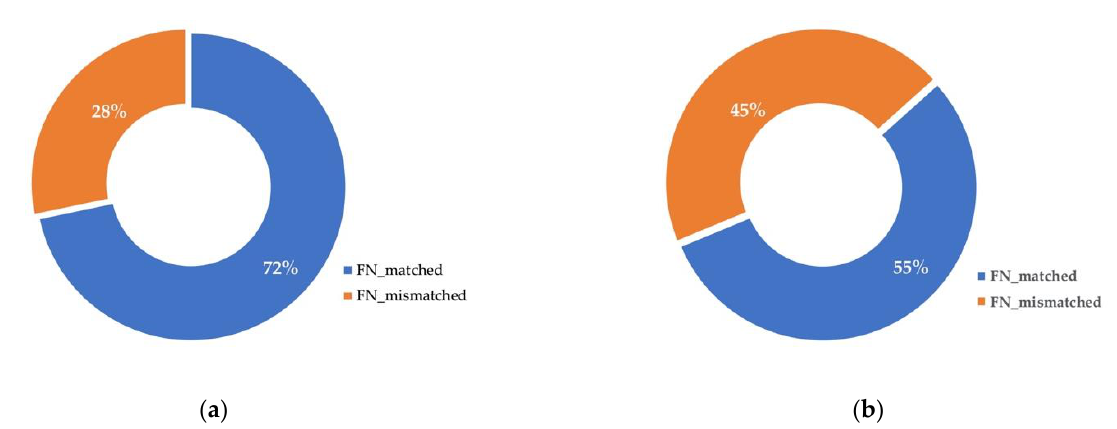
Figure 1. Relationship between FN statistics and common features considered to be FN-related. ( a ) FN statistics of RRC detector [2] on KITTI Tracking Dataset [14]; ( b ) FN statistics of SSD detector [15] on KITTI 2D Object Dataset [14]. Factors considered here include truncation ( ≥ 0.3), occlusion ( ≥ 2, largely occluded), depth ( ≥ 50 m), and height ( ≤ 25 px), the striped partitions show that for both detectors, more than 28% of FNs do not match any of these factors.